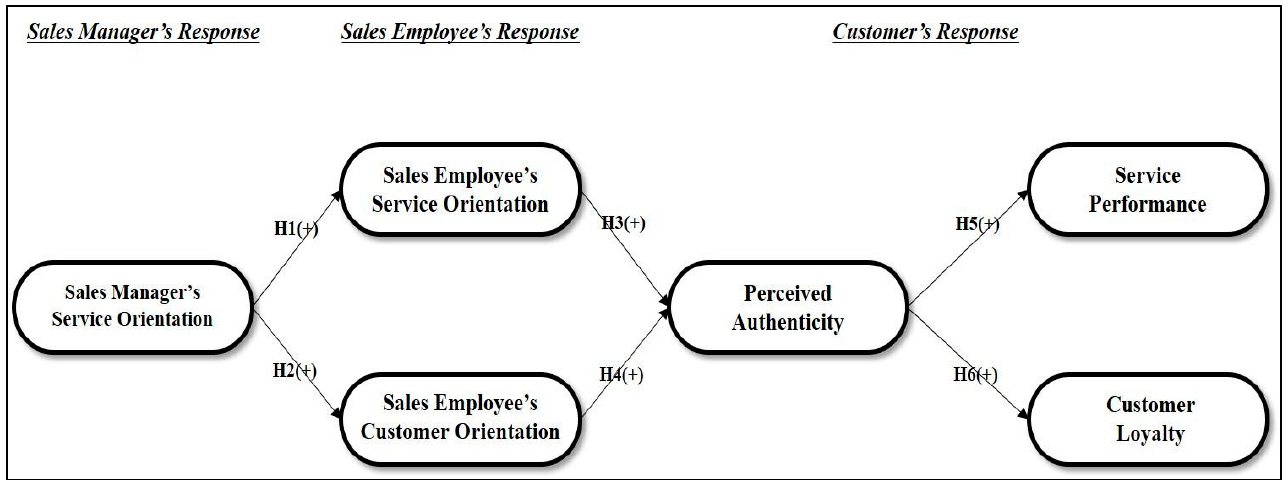
Figure 1. Research model.